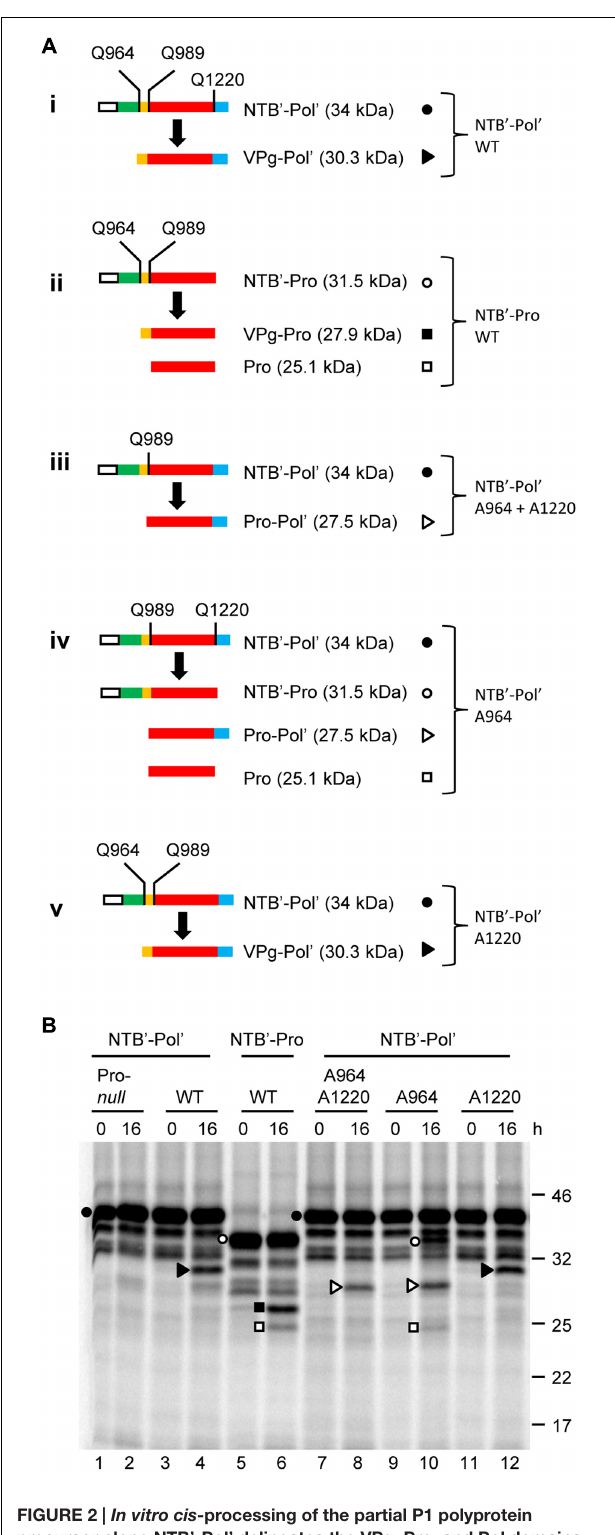
FIGURE 2 | In vitro cis -processing of the partial P1 polyprotein precursor clone NTB’-Pol’ delineates the VPg, Pro, and Pol domains. (A) A schematic representation of the wild-type or mutated derivatives of the NTB’-Pol’ (i and iii–v) or NTB’-Pro (ii) precursor polyproteins and the